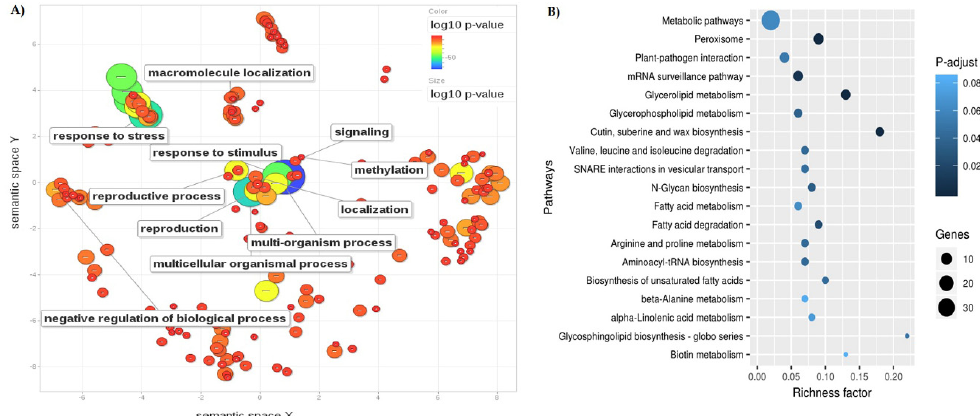
Figure 4. Gene ontology classifications of the differentially expressed genes by the WEGO tool.